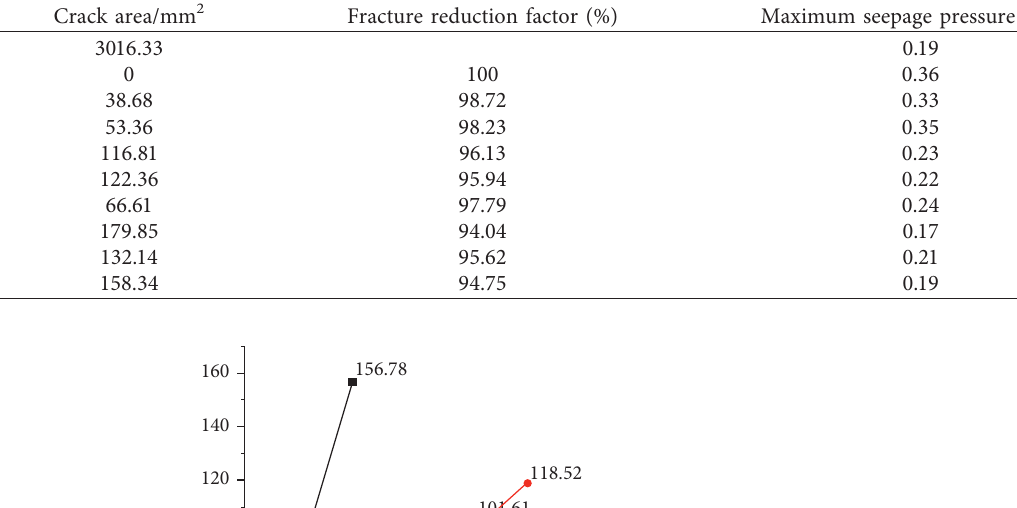
Table 6: Experimental results of anticrack performance and impermeability.